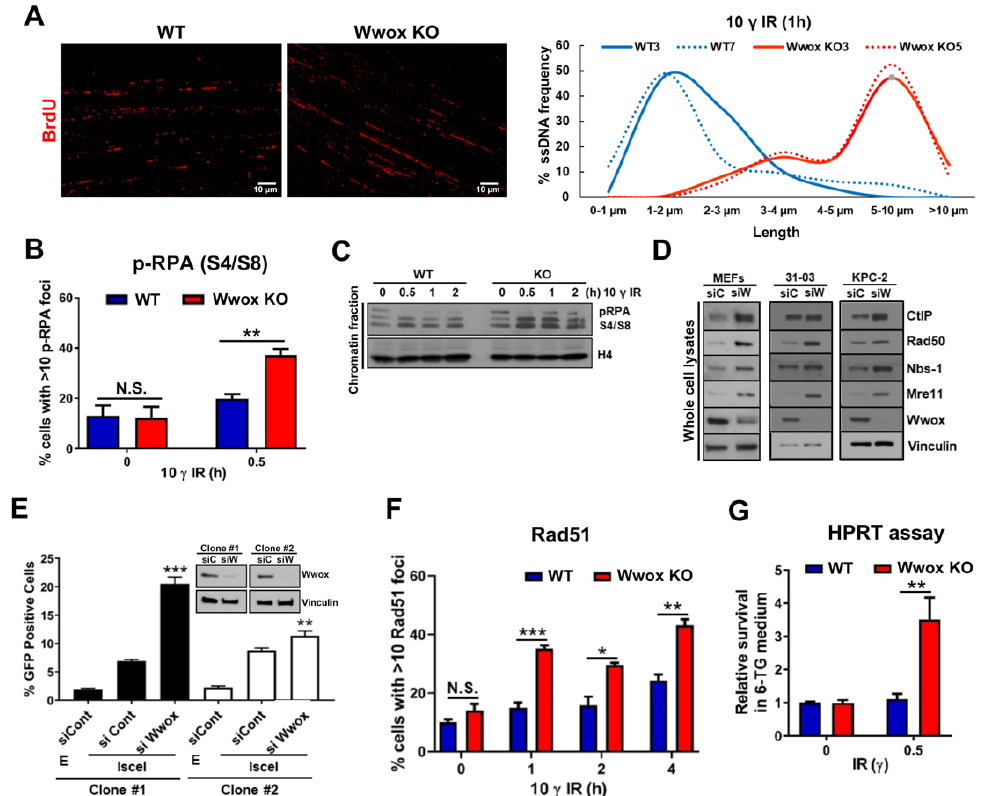
Figure 4. Wwox loss supports rapid initiation of HR through end-resection ( A ) Wwox expression delays the end-resection process. Plots of the ranges of ssDNA length vs. resected ssDNA frequency calculated by SMART assay. Long resected ssDNAs (5–10 µ m) are detected in Wwox KO MEFs 1 h post-IR (10 γ ) vs. the shorter ssDNA (1–2 µ m) present in WT cells. The left panel shows representative images of ssDNA stained by BrdU 1 h post-IR (10 γ ). ( B ) Immunofluorescence of pRPA in WT and Wwox KO MEFs show more pRPA recruitment in the KO cells at 0.5 h after 10 γ IR. Experiments were carried out using two different wild-type (WT3, WT4) and Wwox KO (KO3, KO5) clones in duplicate; ( C ) Immunoblot showing pRPA recruitment into chromatin fraction in Wwox KO vs. WT MEFs after IR. ( D ) Wwox silencing increases steady-state levels of Brca1-C complex proteins including CtIP, Rad50, Nbs1, and Mre11 in three different mouse cells (immortalized MEFs, mammary tumor (31-03) and pancreatic tumor cells (KPC-2)). ( E ) Wwox silencing enhances HR repair following ISce-1-induced DSBs in MEF/DR-GFP reporter cells. Bar graph shows % cells positive for GFP as an indication of relative HR, with corresponding immunoblots of cells carrying HR reporter, DR-GFP, in cells silenced for Wwox expression. ( F ) IR-induced Rad51 foci are increased in Wwox KO MEFs. Experiments were carried out using two different wild-type (WT3, WT4) and KO (KO3, KO5) clones in duplicate. ( G ) DSB repair in Wwox negative cells increases mutation acquisition. Frequency of mutations of the HPRT gene is increased in Wwox KO vs. wild-type WT MEFs following IR exposure. Survival data for the two WT and two KO clones are presented as averages. Error bars represent S.E.M and p -values were calculated by an unpaired t-test (* p < 0.05, ** p < 0.01, *** p < 0.001); N.S., not